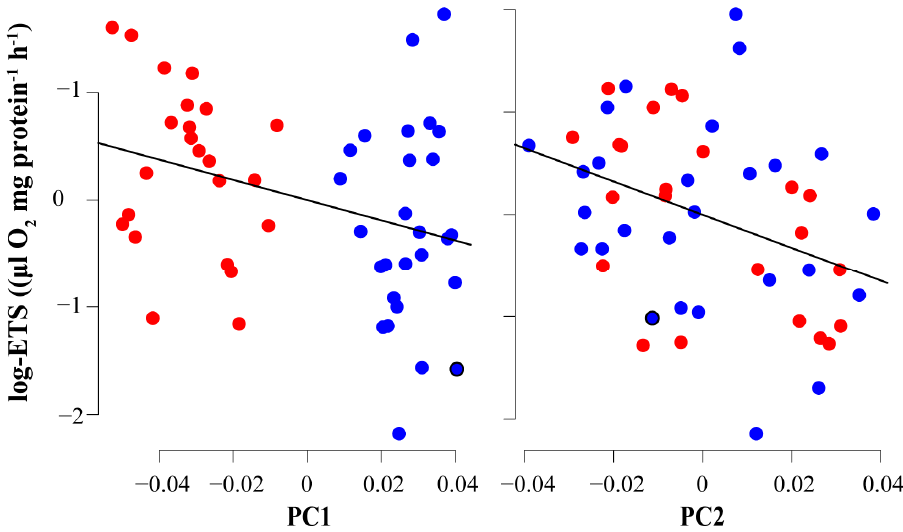
Figure 4. Stepwise regression analysis between the metabolic activity (log- ETS ) and significant PC components during larval and juvenile stages of Chelon auratus . Red dots are larvae (24 dph), blue dots are juveniles (54 dph).